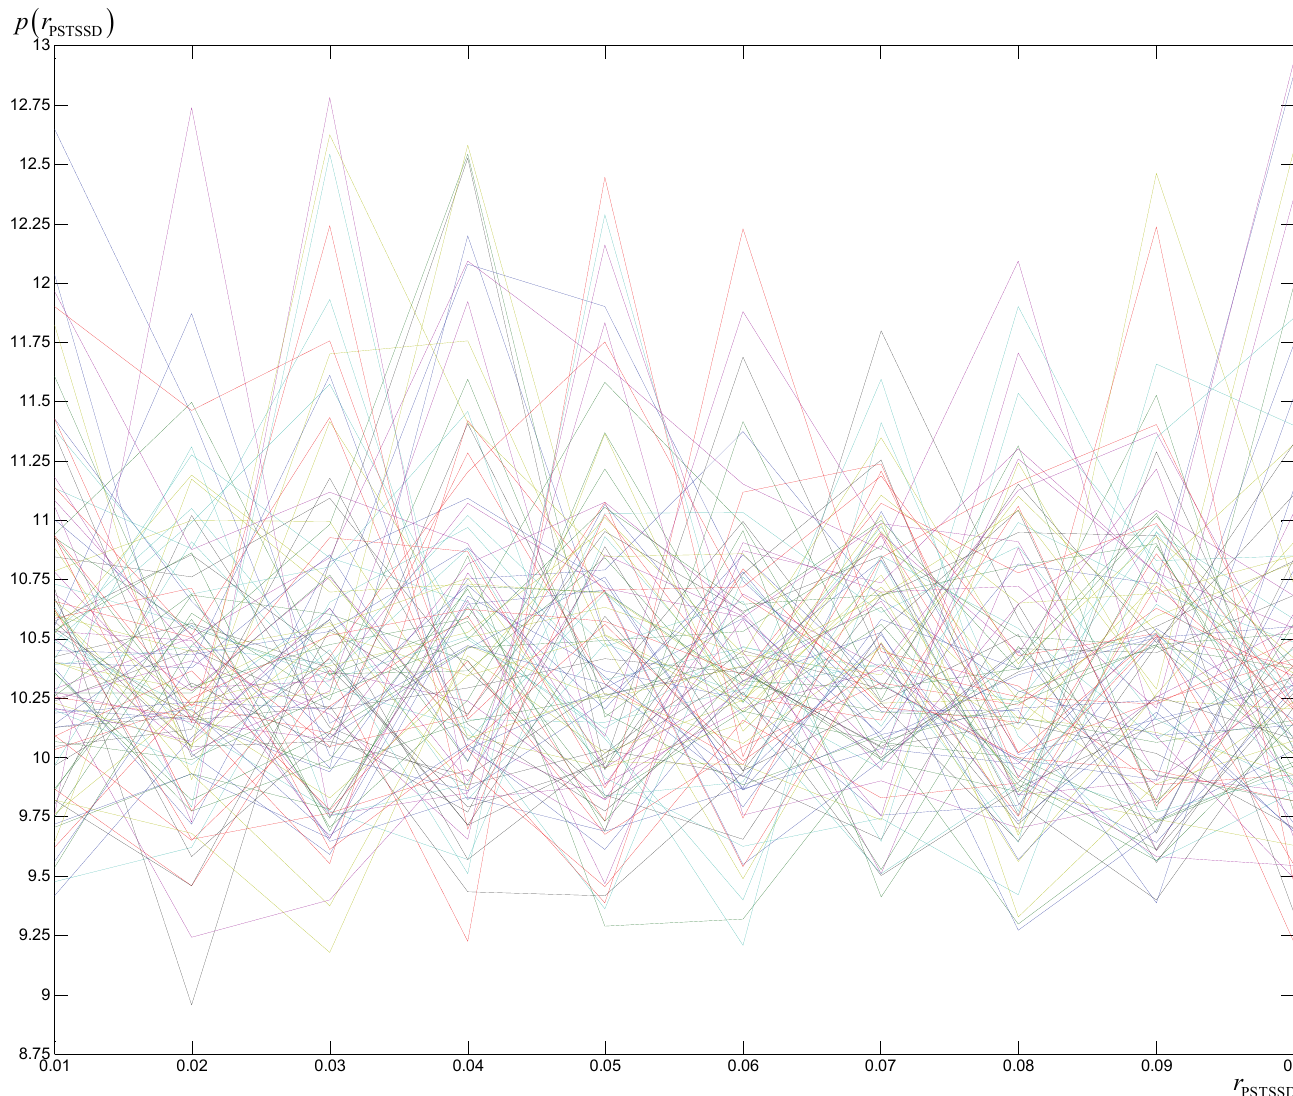
Fig. 4. A bunch of 100 functions (8) for 2LP (22) on the 10-pointed subset (28) showing how CEP is badly scattered (that implies statistical accuracy).